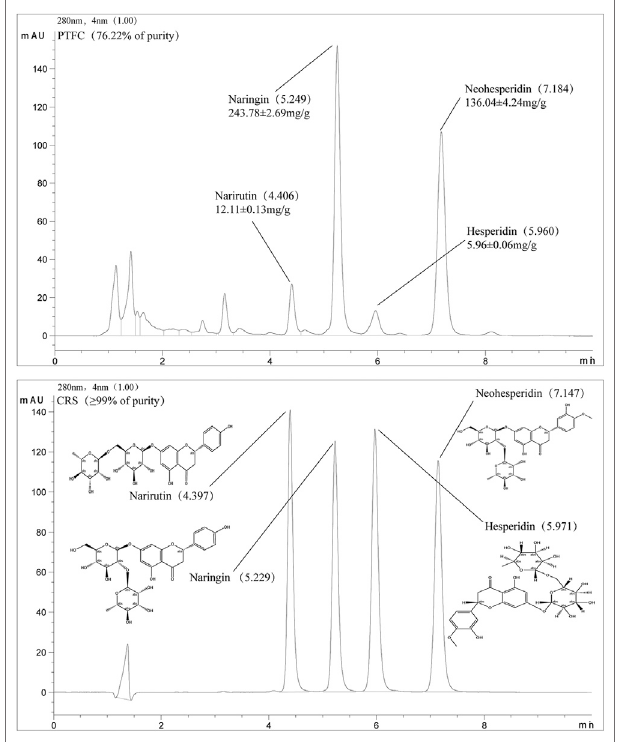
FIGURE 1 | HPLC chromatographic pro fi le of PTFC and standard fl avanones narirutin, naringin, neohesperidin, and hesperidin.